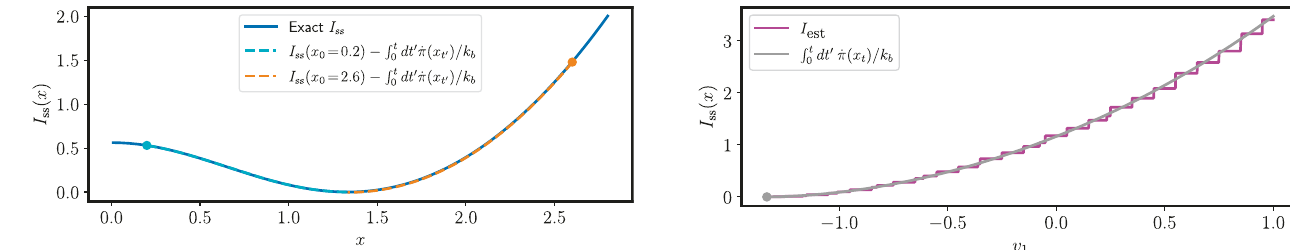
Fig.4|Coarse-grainedboundfortheCMOSmemory. Illustrationoftheboundto I ( x t )fromEq.(18)intermsoftheentropyproductionrate _ π forthecyanandorange trajectories in Fig. 1, starting respectively at x 0 =0.2 and x 0 =2.6 ( V dd =1.4).